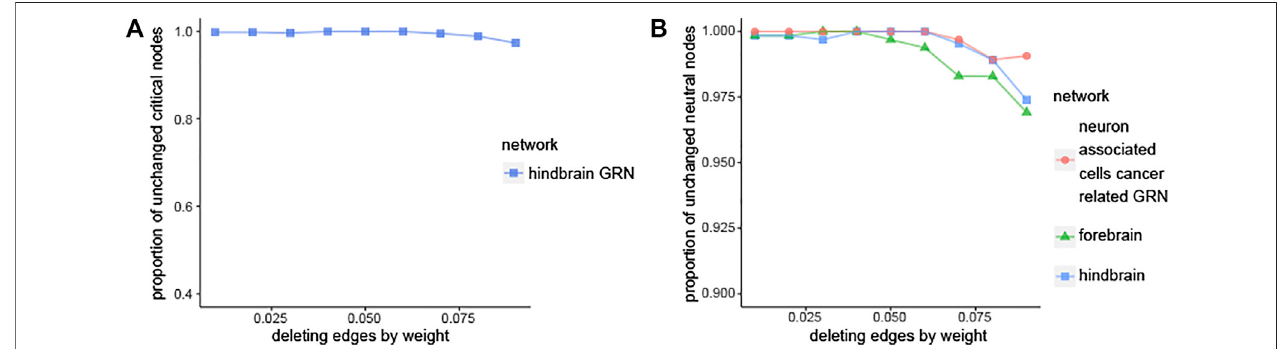
FIGURE4| Robustnessanalysisofnodeclassi fi cation. (A) PlotshowingthefractionofciriticalnodesinnewnetworksthatoverlapswiththeoriginalhindbrainGRN, the new networks are obtained by deleting edges from original hindbrain gene regulatory networks. (B) The comparison of three networks in case of deleting edges.